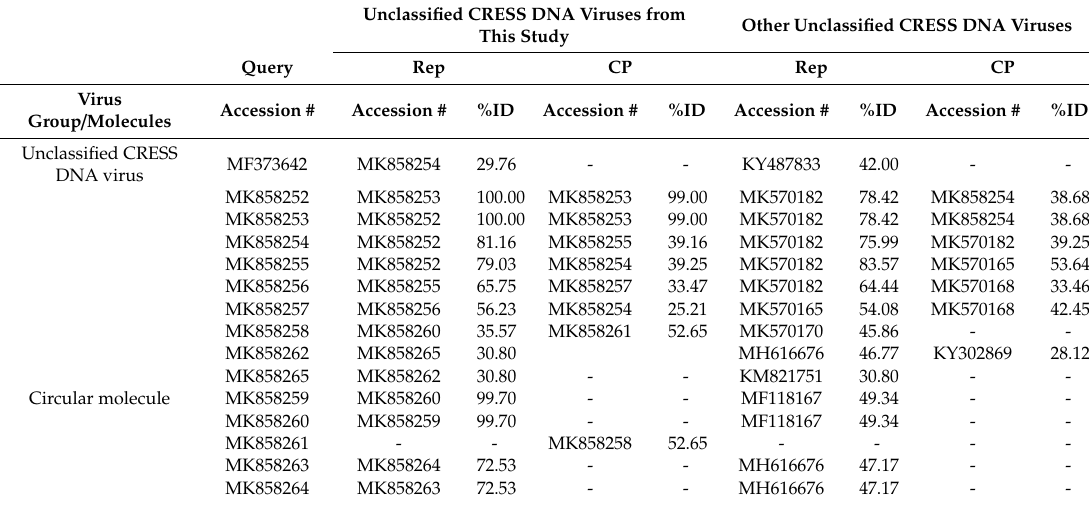
Table 4. Pairwise identities (showing highest identity) of the replication associated protein (Rep) and capsid protein (CP) amino acid sequences of the unclassified CRESS DNA viruses and circular molecules identified in this study against themselves and against those available in GenBank. Unclassified CRESS DNA Viruses from Other Unclassified CRESS DNA Viruses This Study Virus Group /